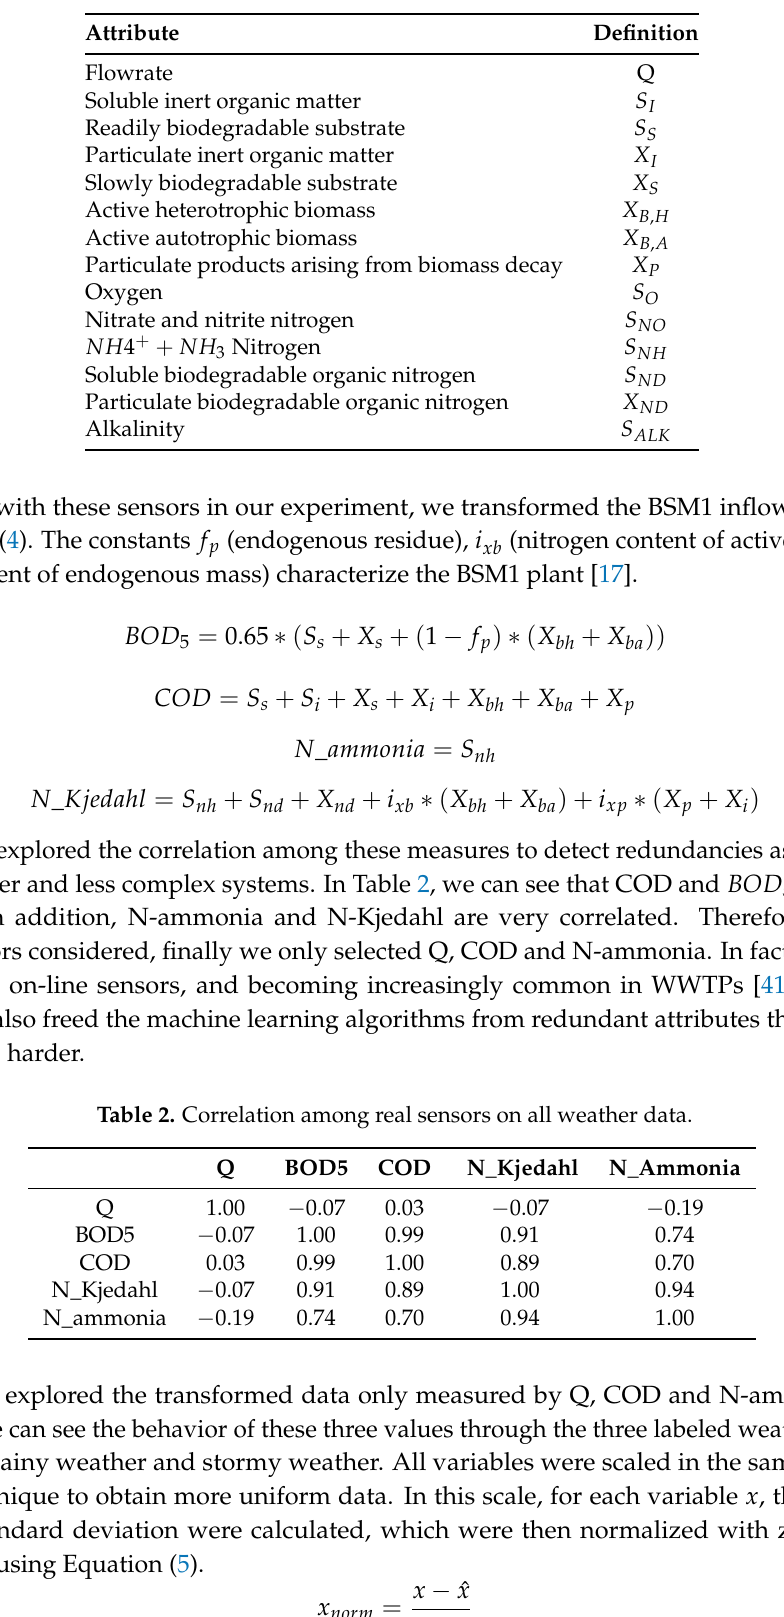
Table 1. Attributes that characterize the inflow in the BSM1 plant.